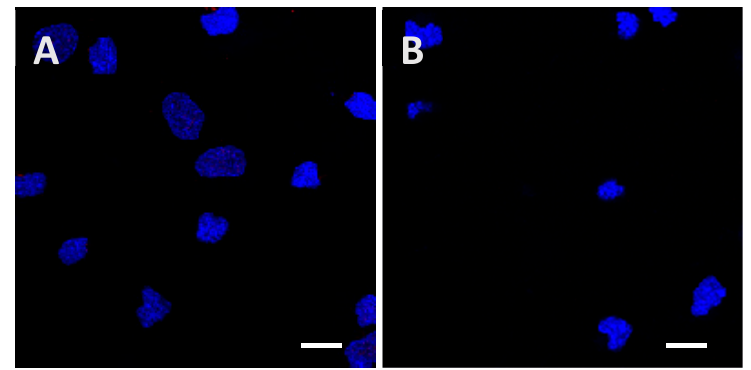
Figure A3. Determination of the minimal concentration needed to observe internalization of the low phosphorylated Tau protein inside cortical cells after 24 h of incubation. Initial protein amounts of 1.5 µ g ( A ) and 4.5 µ g ( B ) were used, but no signal was detected until 15 µ g of the protein were added (Figures 2E and 3E). Scale bars, 10 µ m.